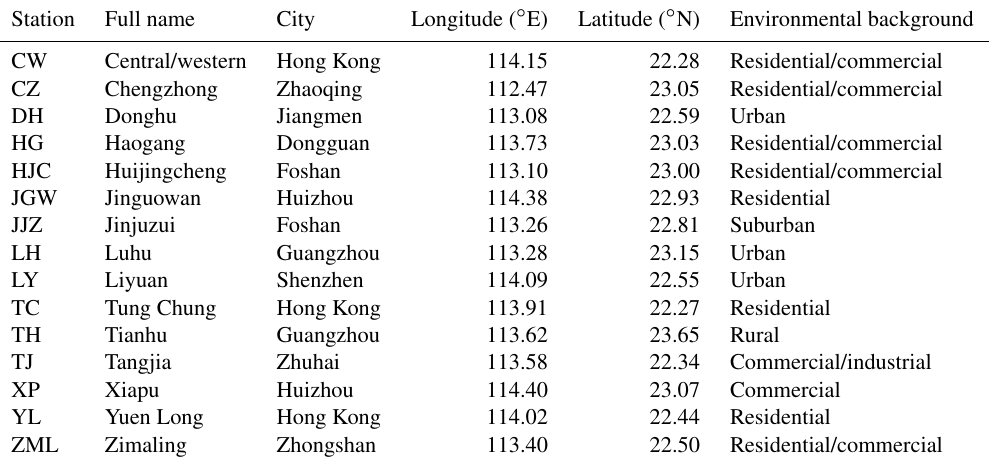
Table 1. Location of 15 ozone monitoring stations across the Pearl River Delta and their environmental background.